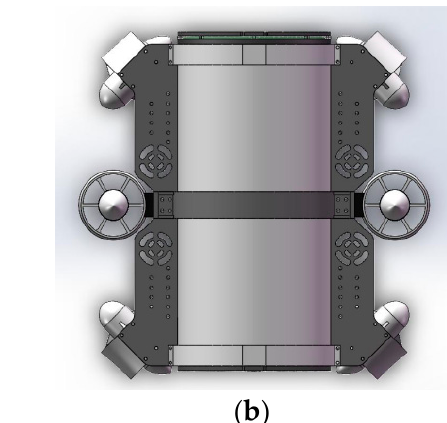
Figure 2. Visualization of the entire ocean environment and the modeling process of the seabed.